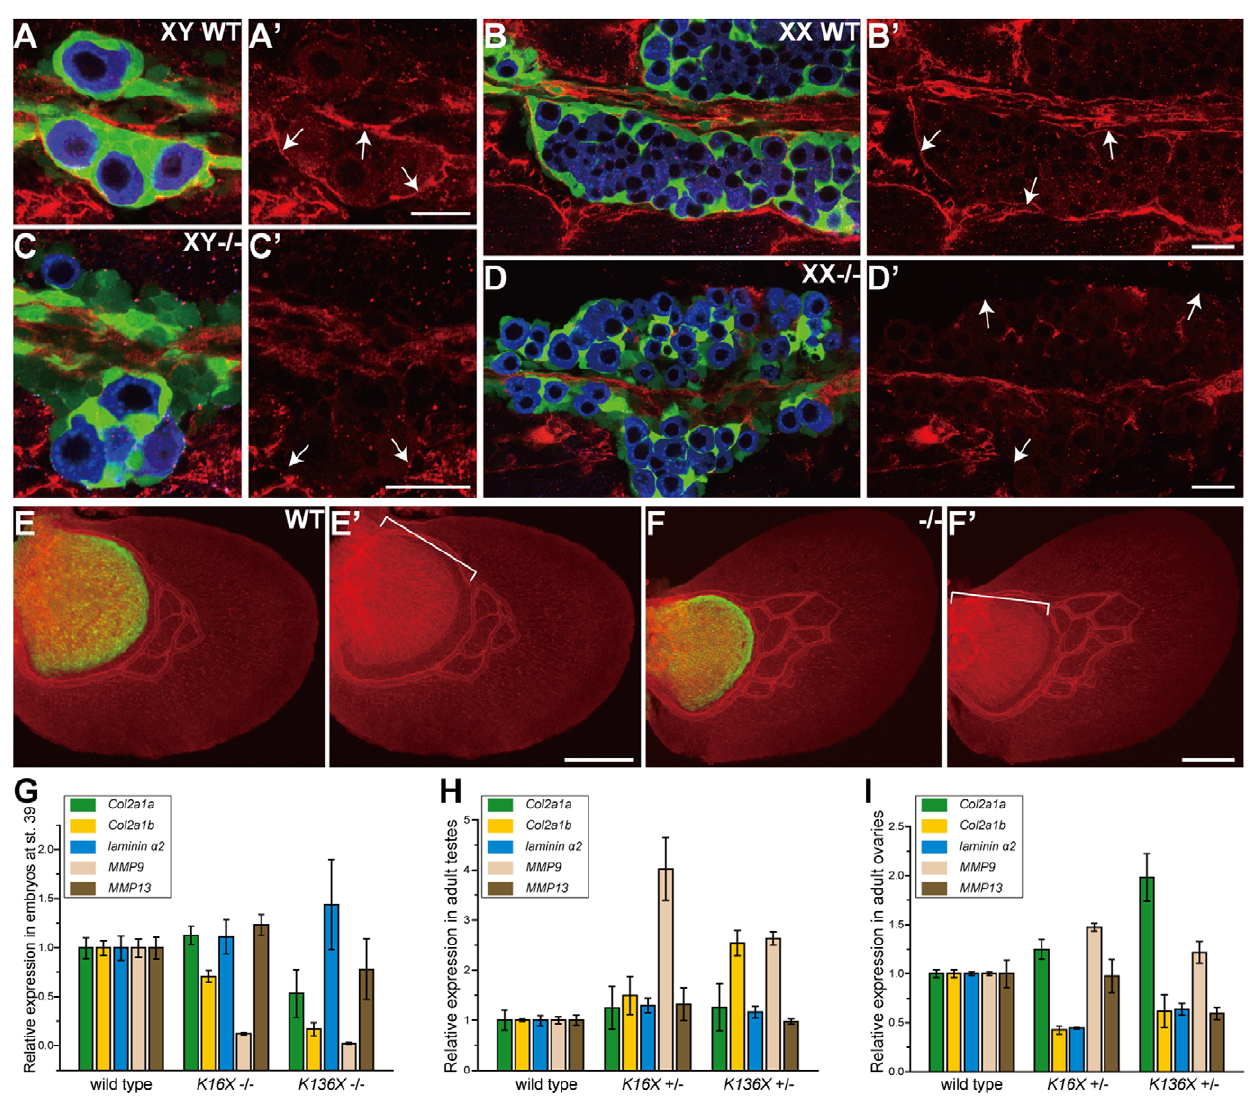
Figure 7. The deposition of ECM components is altered in sox9b medaka mutants. (A–D 9 ) Ventral views of wild-type and sox9b K16X 2 / 2 medaka gonads at stage 39. Laminin (red), sox9b -EGFP (green) and germ cells detected by OLVAS antibody (blue) are shown. Note that the laminin deposits detected in wild-type sox9b -expressing cells are disorganized in the mutant cells (A 9 , B 9 , C 9 and D 9 , arrow). (E–F 9 ) The wild-type and sox9b K16X 2 / 2 pectoral fin at stage 39. Laminin (red) and sox9b -EGFP (green) signals are shown. The laminin expression pattern (brackets in E 9 and F 9 ) is unchanged in the mutant pectoral fin, in which both sox9a and sox9b are expressed. (G–I) The relative mRNA expression levels of extracellular matrix (ECM) components and matrix metalloproteases (MMP) in stage 39 medaka embryos (G), and the adult testis (H) and ovary (I) determined by qRT-PCR. The intensity of each band was normalized to EF1 a and the relative expression levels compared with wild type are shown. Note that some ECM components and MMP are upregulated or downregulated in mutants compared with wild type. Each value represents the mean 6 s.e.m. (n=4). Scale bars, 20 m m and 100 m m (E–F 9 ). mutants can survive until 20 dph. This is in contrast to the embryonic lethality seen in the Sox9 -disrupted mouse embryo. The discrepancy in these survival outcomes between medaka and mouse could be attributable to the redundant expression of sox9a and sox9b in the medaka.